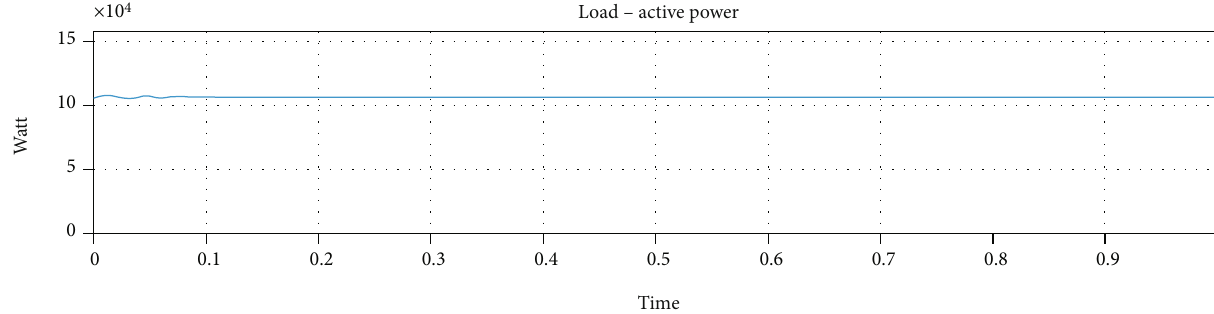
Figure 29: Real power consumed by load.